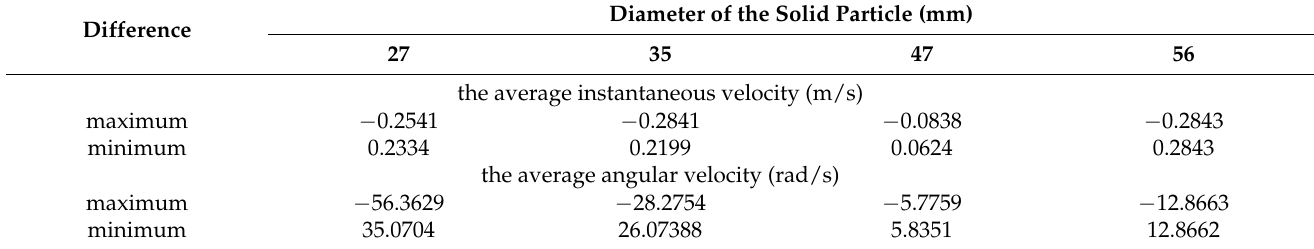
Table 4. Minimum and maximum residual values [44].